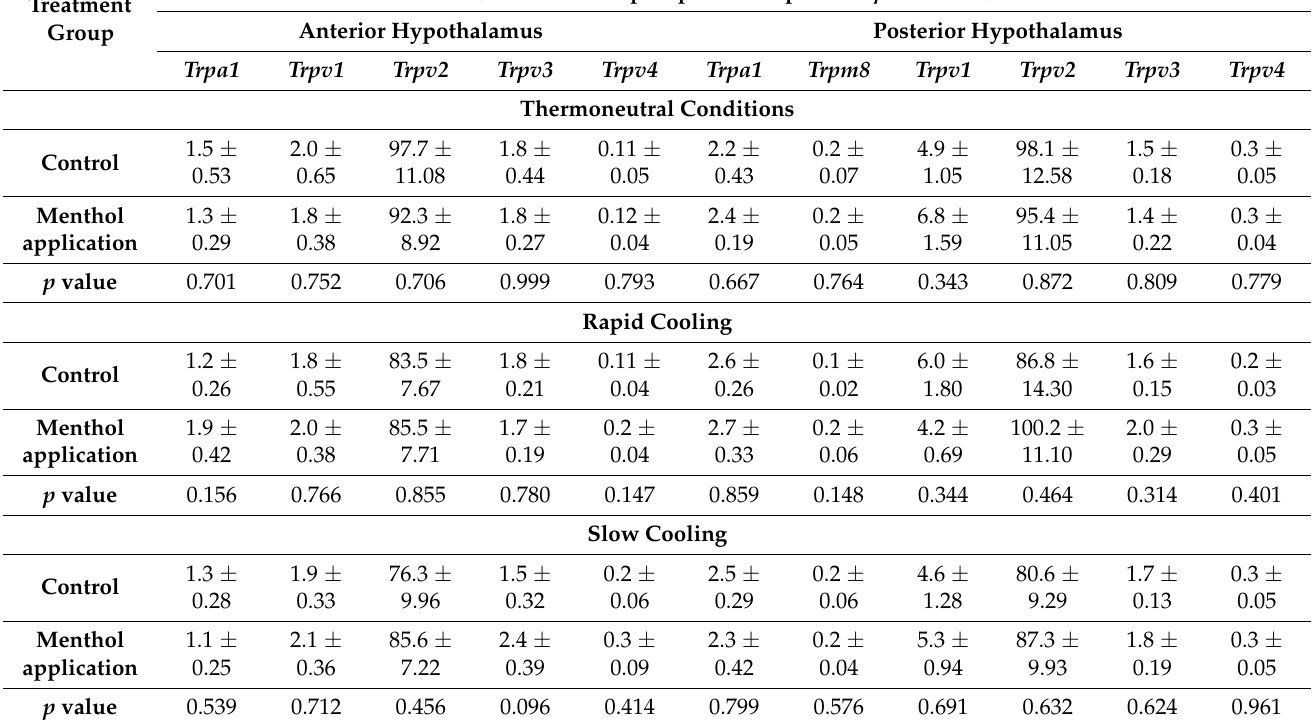
Table 2. mRNA levels of the genes of thermosensitive TRP ion channels in the anterior and posterior parts of the hypothalamus in hypertensive rats, control animals and animals subjected to the periph- eral TRPM8 ion channel activation by menthol under thermoneutral conditions and with subsequent cooling. Number of rats is 10 for each